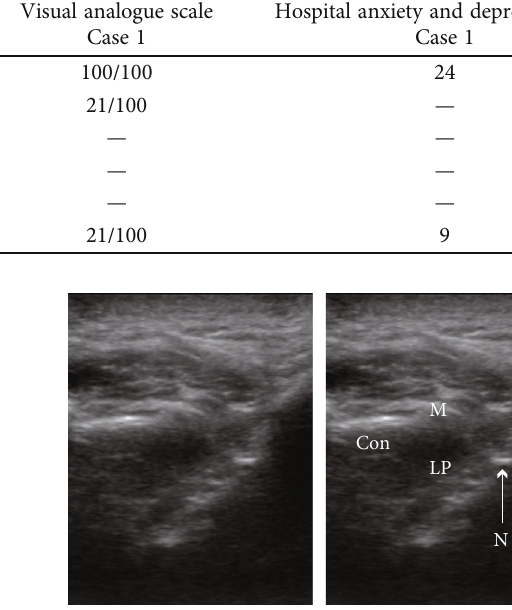
Figure 2: Intraprocedural image of ultrasound-guided IANB. We con fi rmed the spread of the local anaesthetics (6 ml of 0.375% ropivacaine). Cor: coronoid; Con: condyle; M: masseter; LP: lateral pterygoid muscle; N: needle.